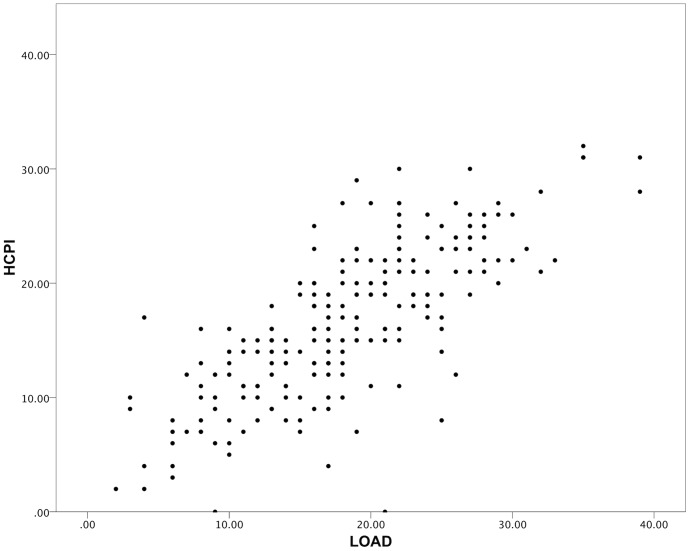
Scatterplot of LOAD versus HCPI scores for the cross-sectional cohort.There is a significant, moderate correlation typical of inter-instrument comparisons. Spearman’s Rank Correlation Coefficient = 0.77 (p<0.01).